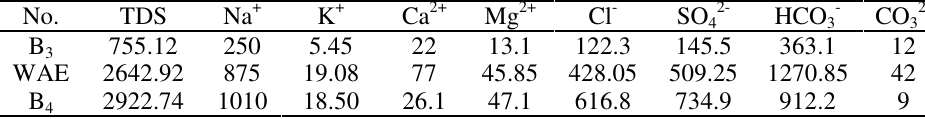
B and WAE (Unit: mg/L) 4, 3